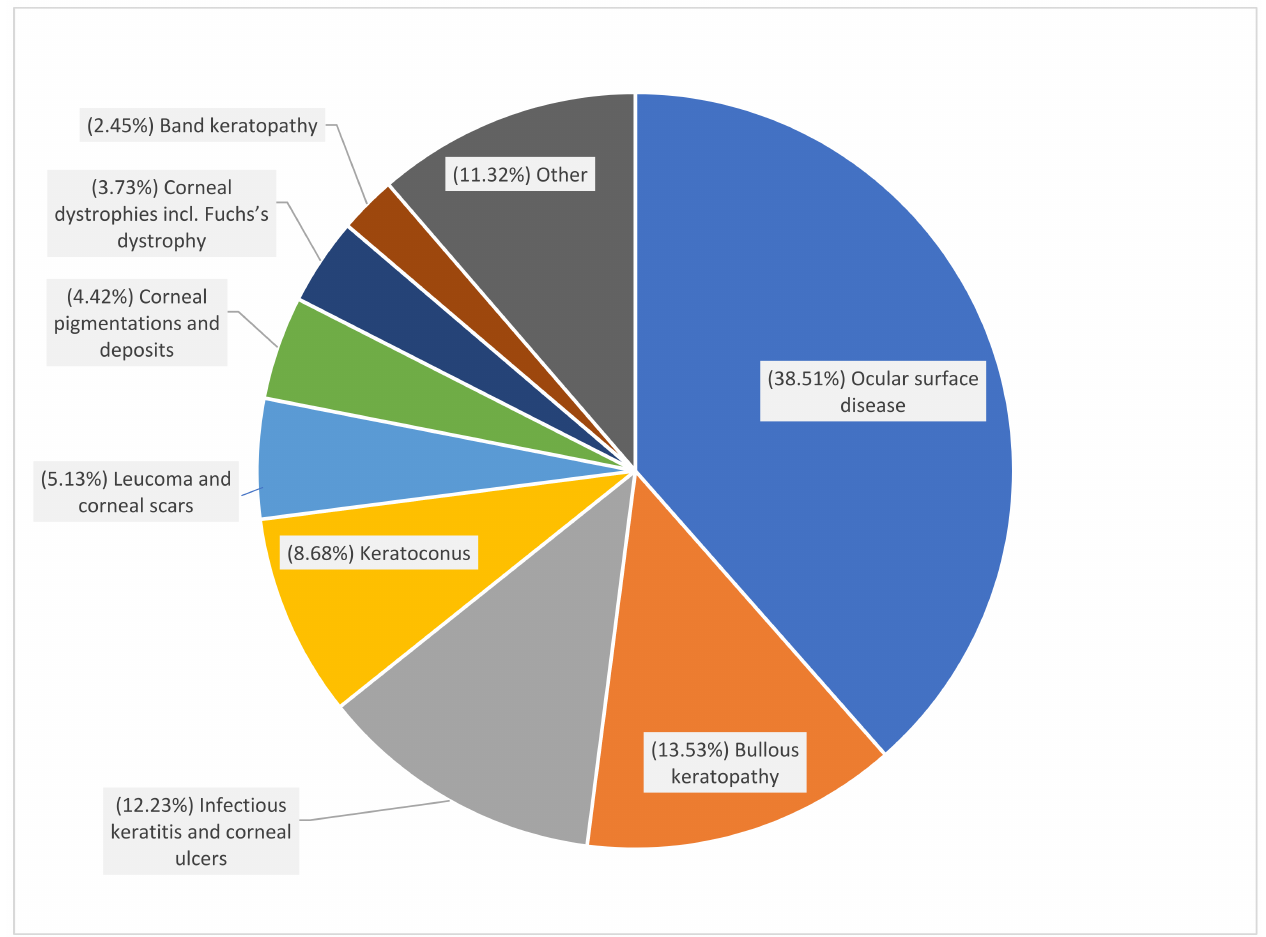
Figure 2. Indications for corneal grafts in Poland in the years